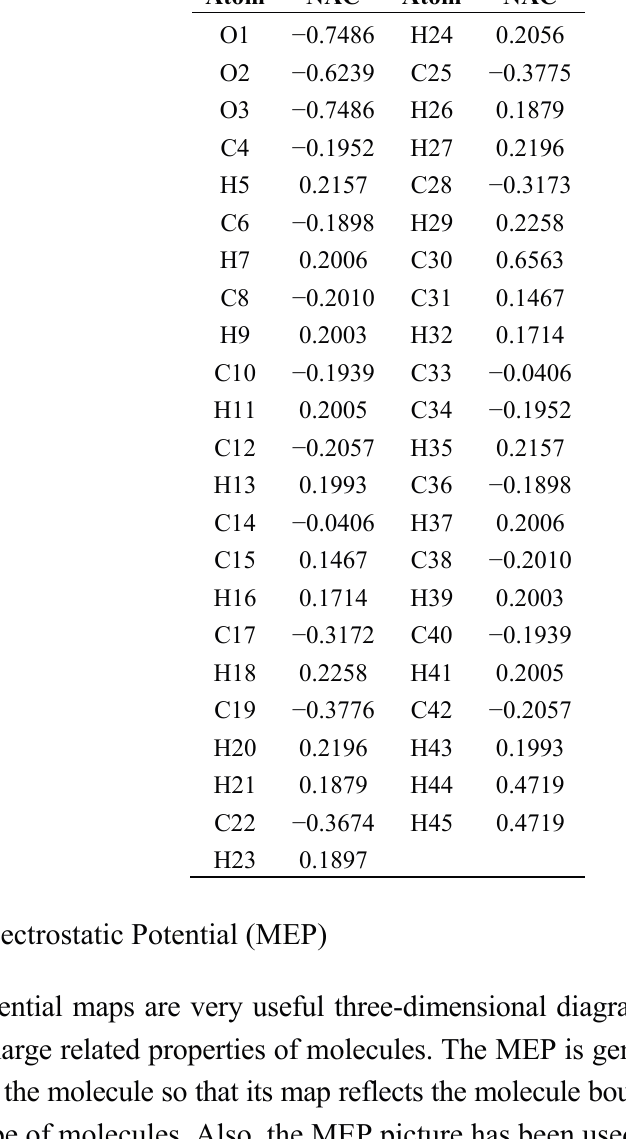
Table 4. The natural atomic charges calculated at the B3LYP/6-311G(d,p). Atom